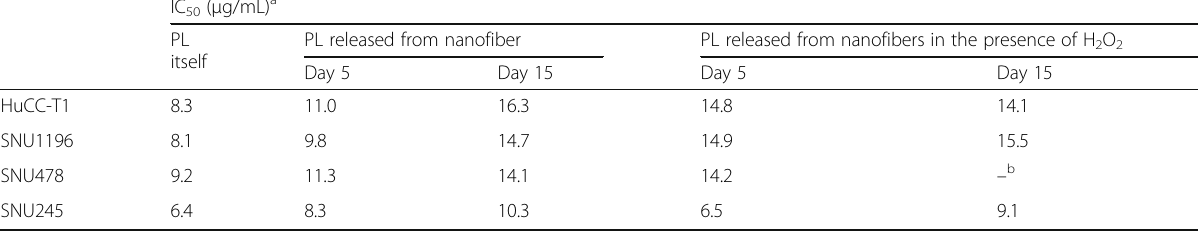
Table 3 IC 50 of PL itself and released PL from nanofiber mats against various CCA